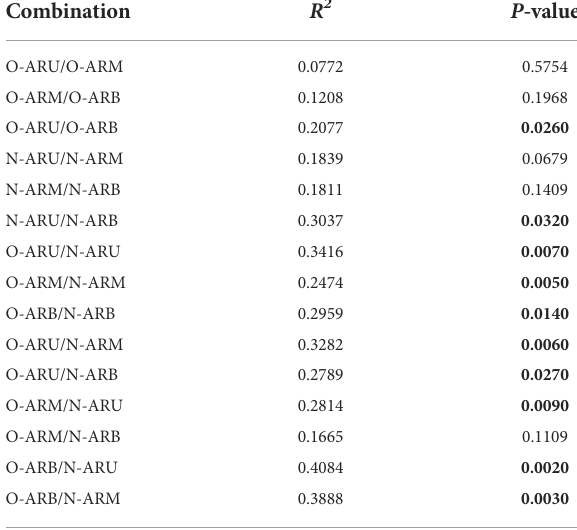
TABLE 3 PERMANOVA test for differences in sampling location and construction